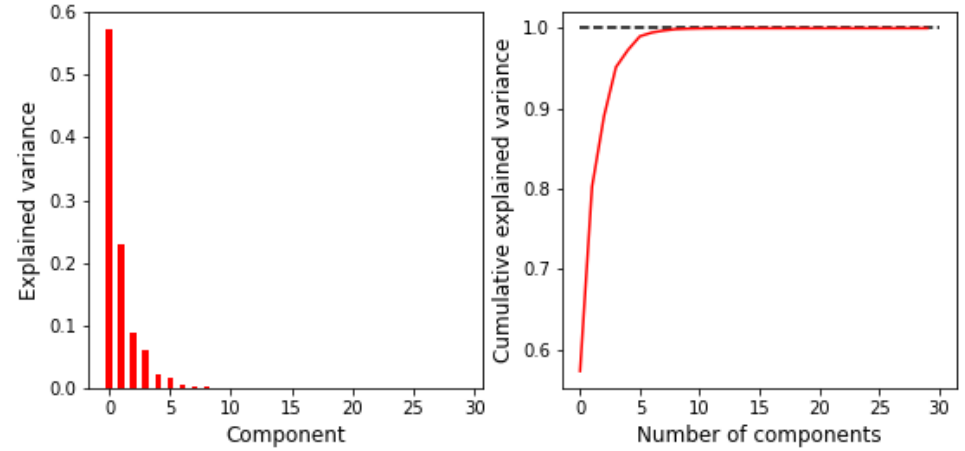
Figure 10. Principal component analysis explained variance plots. The ( left ) panel shows the percentage of explained variance by particular components. The ( right ) panel presents the cumulative variance explained by the first k